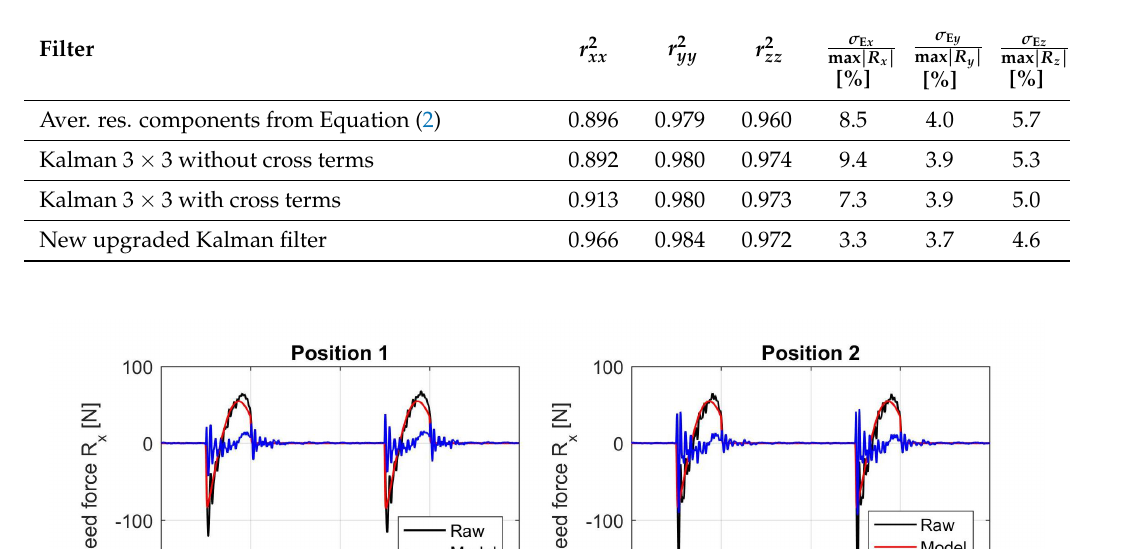
Table 3. Adequacy of filtered forces to the cutting force model.